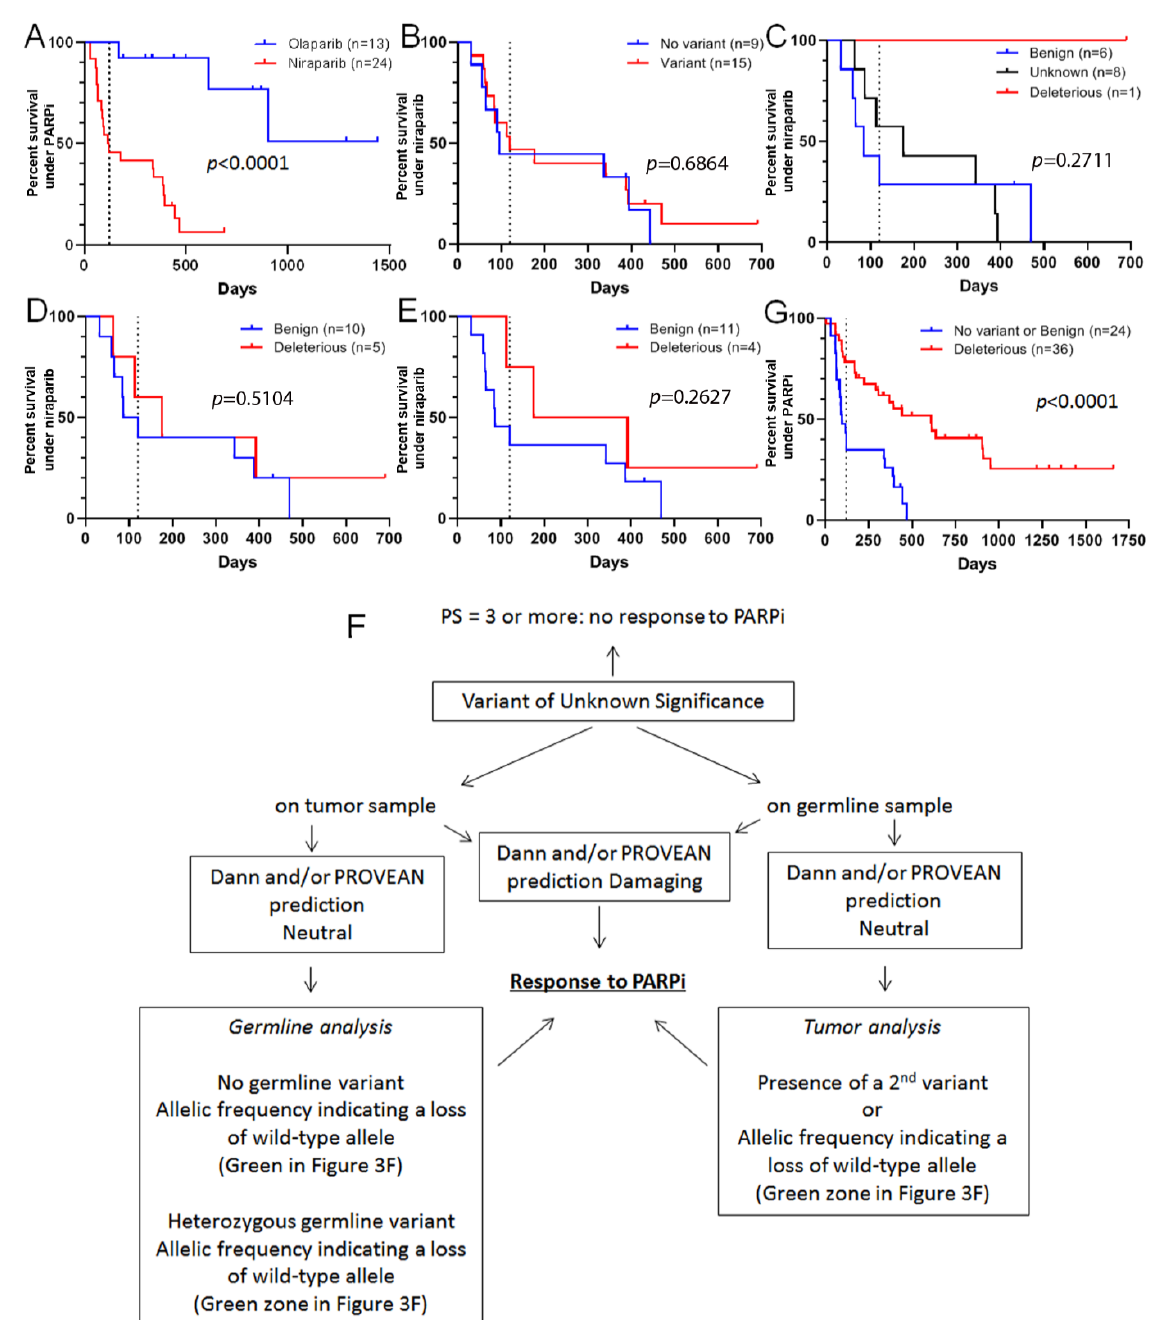
Figure 4. Progression-free survival (PFS) of patients with ovarian cancer treated with a PARP inhibitor. ( A ): PFS of 37 patients prospectively treated with either olaparib (blue) or niraparib (red) in compliance with the approved indication for clinical use. ( B ): PFS observed for 24 patients treated with niraparib according to the absence (blue) or presence (red) of variants, whatever their pathogenicity. ( C ): PFS observed for patients with tumors harboring benign (blue), VUS (black) and pathogenic (red) variants in response to niraparib. ( D – E ): PFS under niraparib treatment according to variant pathogenicity predicted by combination of loss of wild-type allele, Performance status and Dann ( D ) or PROVEAN ( E ) predictions. ( F ): A proposal of a tree to guide treatment decisions in case of VUS-containing tumors. ( G ): PFS observed for 60 patients with ovarian cancer treated with a PARP inhibitor (olaparib or niraparib) according to the absence of a variant, or the presence of a known or predicted benign variant (blue), and the presence of a known or predicted deleterious variant (red). Only statistically significant results are indicated on the graphs. For all panels: the dashed line corresponds to 120